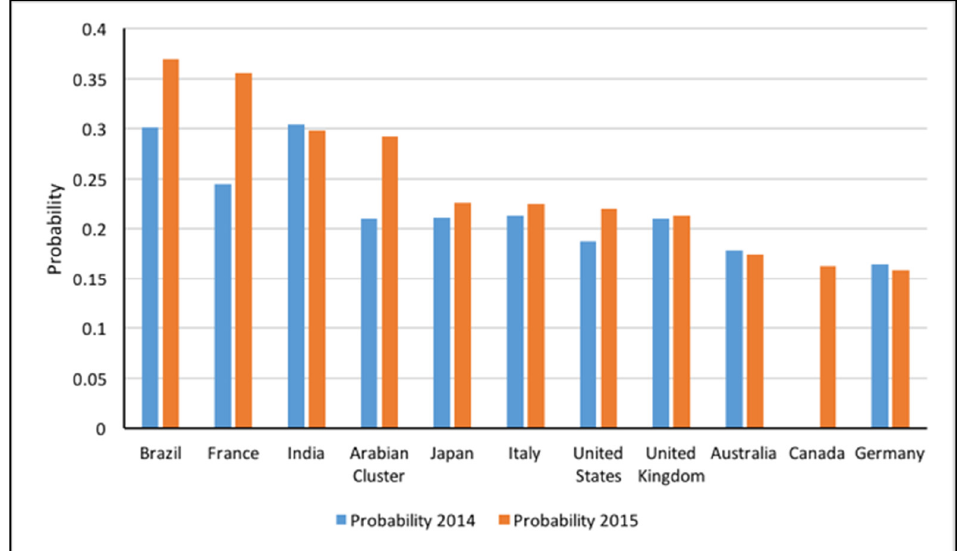
Figure 6. Data breach probability by country (Ponemon data 2015) [36].